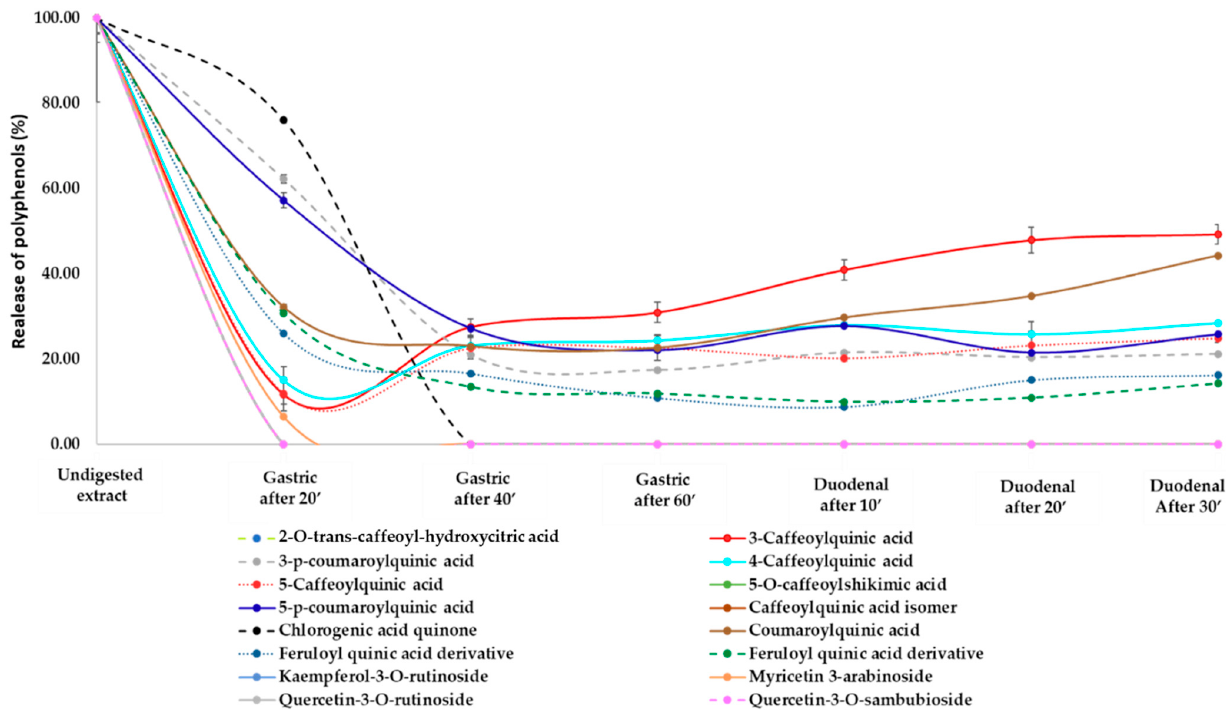
Figure 5. Dynamic evaluation of the release of polyphenolic compounds content during the in vitro simulated human digestion. Values represent averages ( ± SD) of triplicate measurements. RSD was always